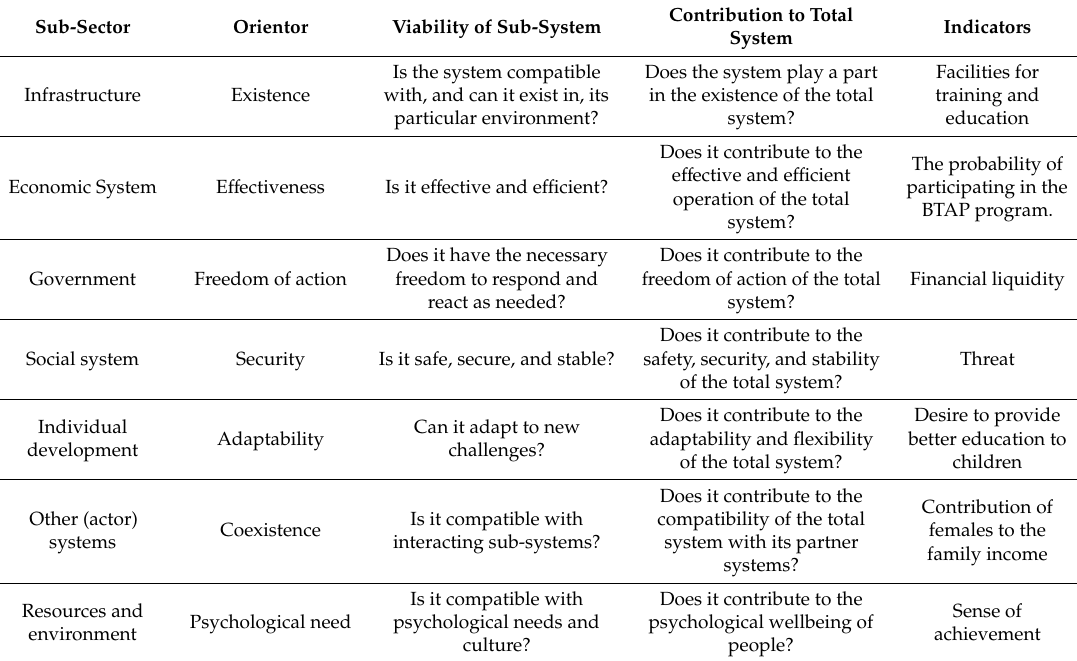
Table 3. Sub-sectors, orientors, and